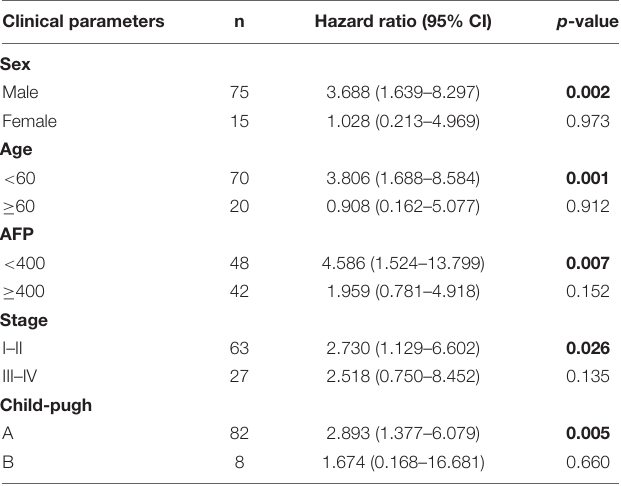
TABLE 2 | Univariate survival analysis of MRGBP expression in subgroups with different clinical parameters. Clinical